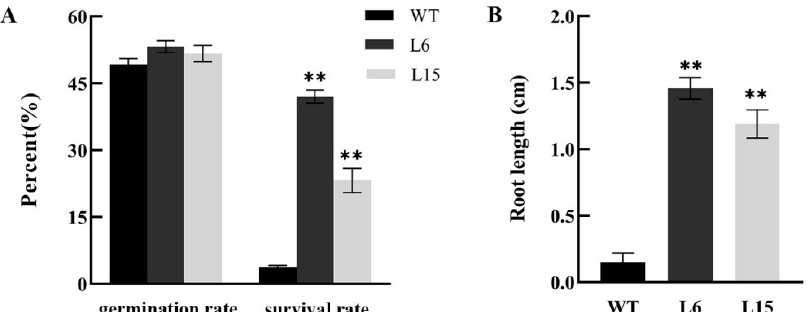
Figure 8. Low nitrogen tolerance analysis of CpSRG1 transgenic and wild-type Arabidopsis. ( A ) Germination rate and survival rate under low nitrogen treatment. ( B ) Root length. WT (wild-type plants, Col-0); L6 & L5, transgenic plants overexpressed CpSRG1 . Data represent mean of three biological repeats ± SEM. Error bars indicate the standard error of mean. Asterisks denote statistically significant differences compared with control, ** p < 0.01.